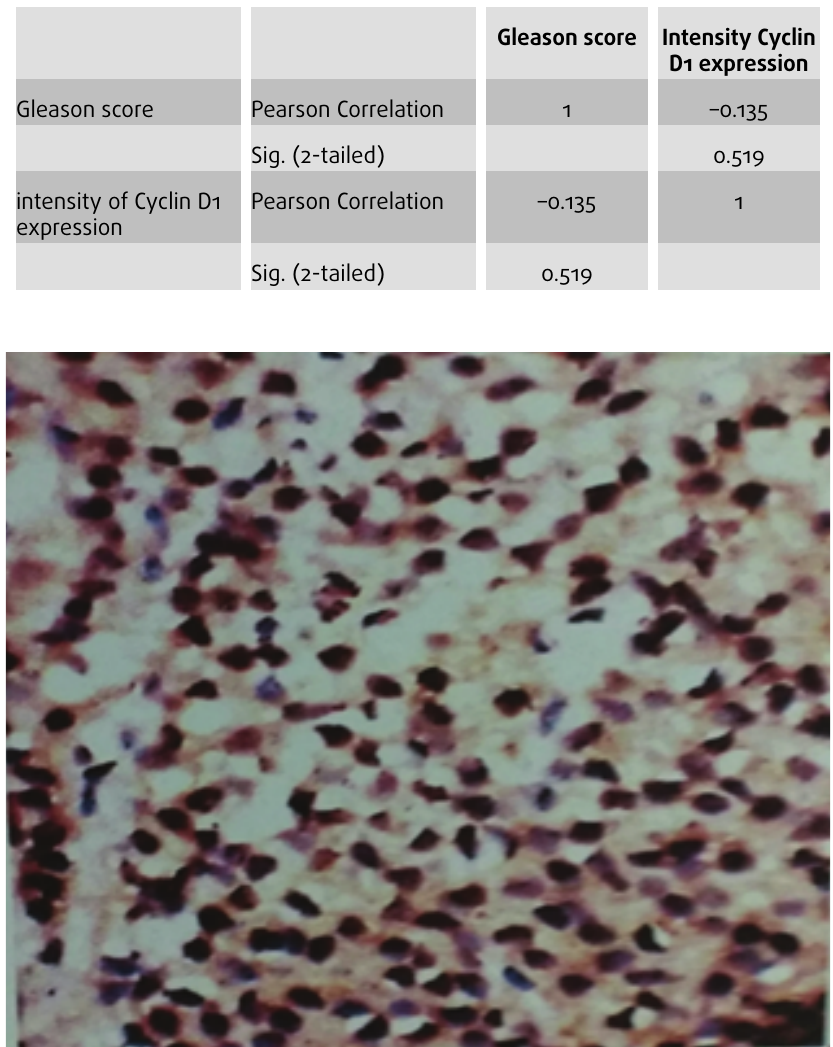
Figure 1: Clear cell carcinoma, showing strong nuclear cyclin D1 staining, grade 3+ (cyclin D1 Olympus digital camera).